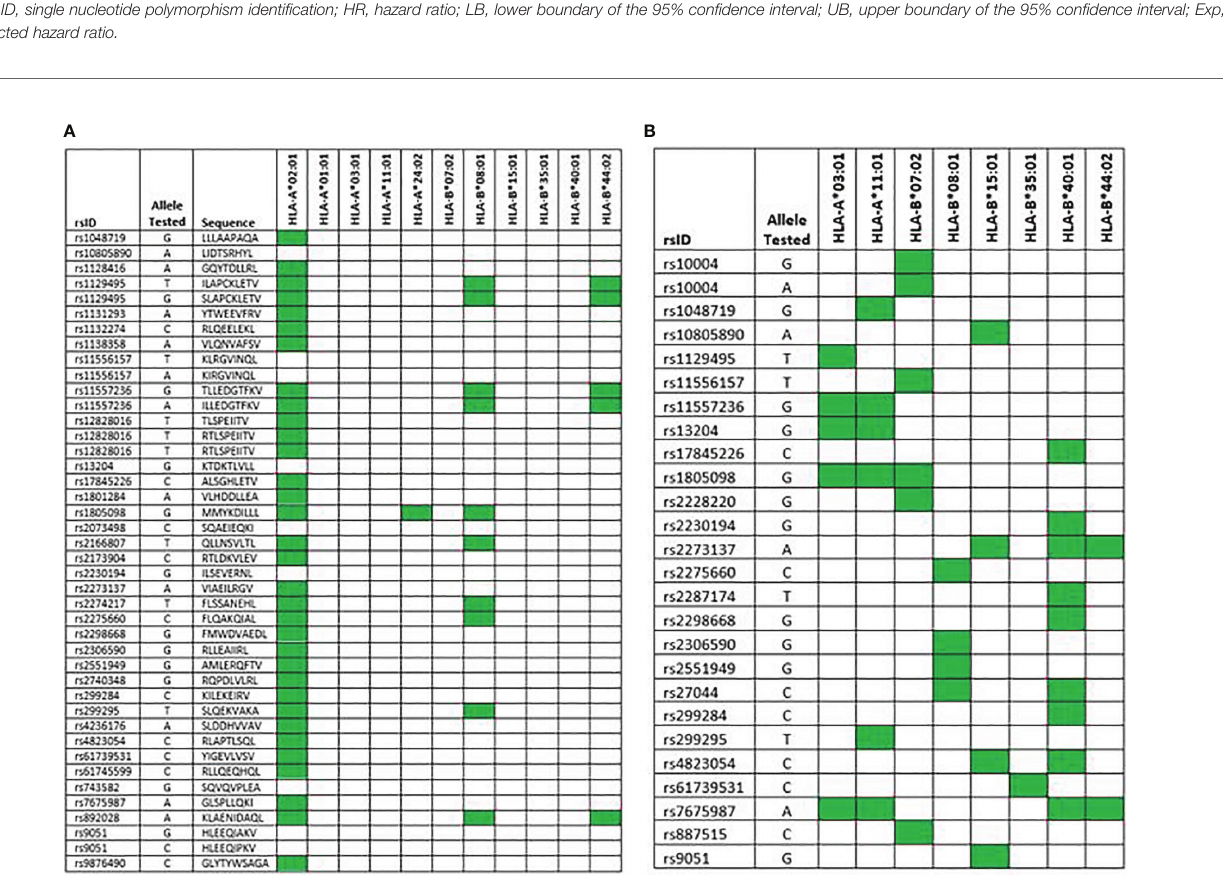
FIGURE 5 | HLA-A*02:01-associated minor histocompatibility antigen peptides are predicted to bind promiscuously to other HLA-A and B allotypes. The HLA- allotypes shown in the columns include all that have allele frequencies >0.05 in the USA NMDP European Caucasian population. (A) Predictions are based on analysis of 9-mer and 10-mer peptides reported to bind HLA-A*02:01. Filled cells indicate the predicted binding of 9-mer and 10-mer peptides according to the PromPDD algorithm. (B) Predictions are based on analysis of HLA-A*02:01 minor histocompatibility antigen source peptides according to the NetMHCpan4.1 algorithm at the default setting. Filled cells indicate processed 9-mer peptides that include the variant amino acid residue and were identi fi ed as strong binders with <500 nM predicted af fi